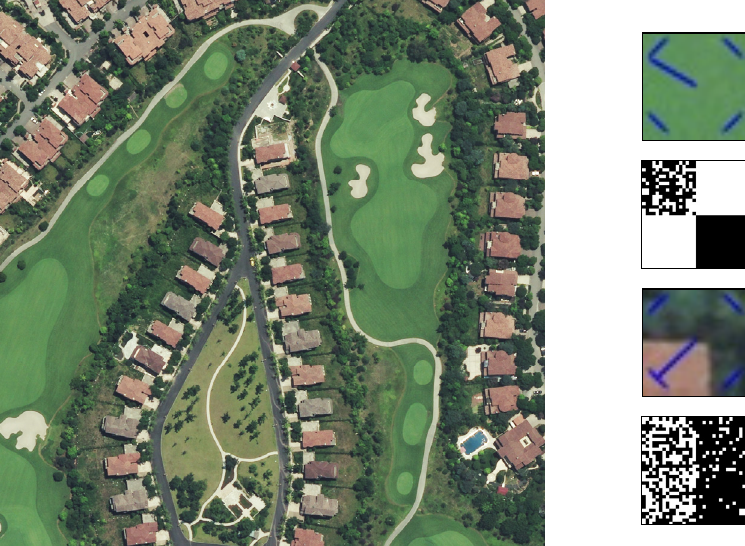
Figure 3. Original patch and BUT